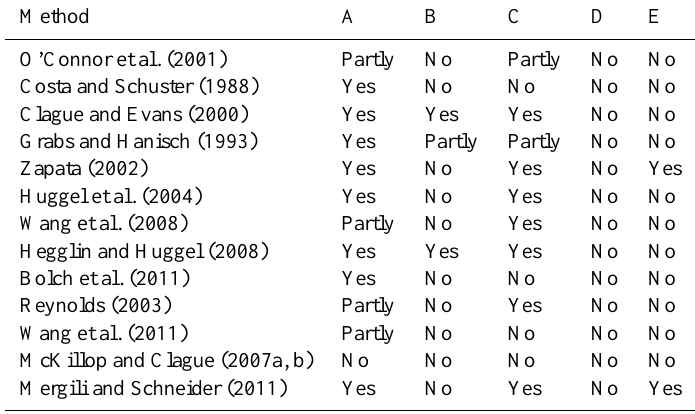
Table 12. The methods with regard to whether they take into consideration the regional specifics of the Cordillera Blanca. Method A B C D E O’Connor et al. (2001) Partly Partly Costa and Schuster